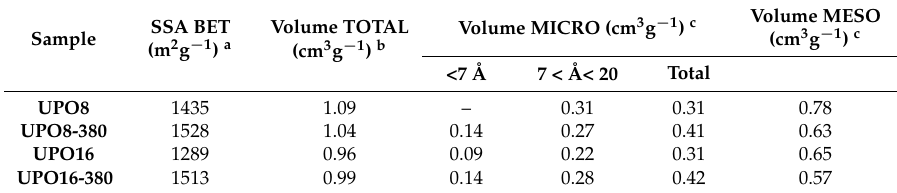
Table 1. Textural properties (BET surface area and pore volume) for the samples before and after thermal